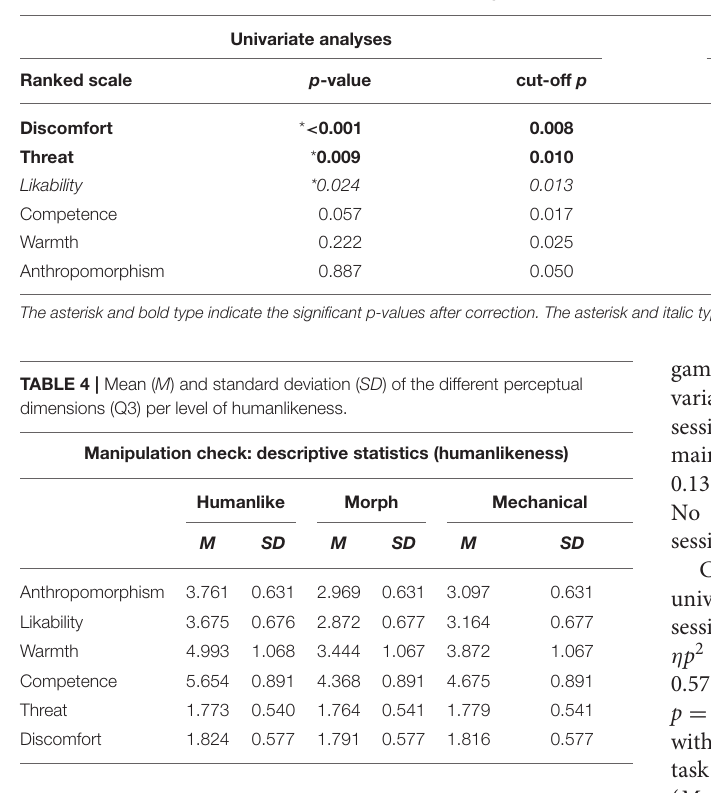
TABLE 3 | Ranked p -values for the univariate analysis and between-subjects effects referring to the manipulation check with corresponding cut-off p -values due to Holm-Bonferroni correction. Manipulation check: Holm-Bonferroni correction Univariate analyses Between-subjects effects